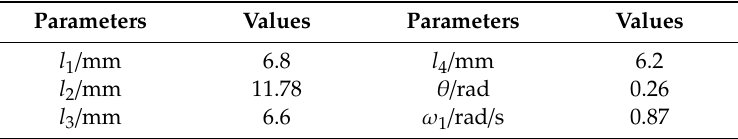
Table 4. Parameters of the expanding mechanism.